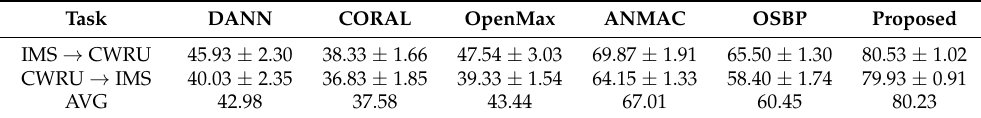
Table 6. Diagnosis results in the different equipment (accuracy (%) ± standard